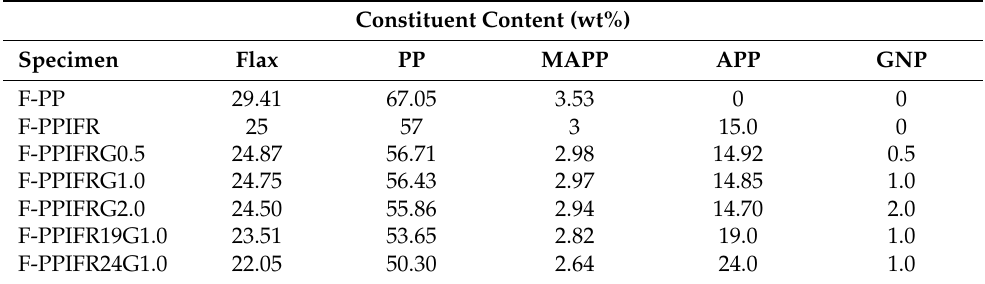
Table 3. Composition of the